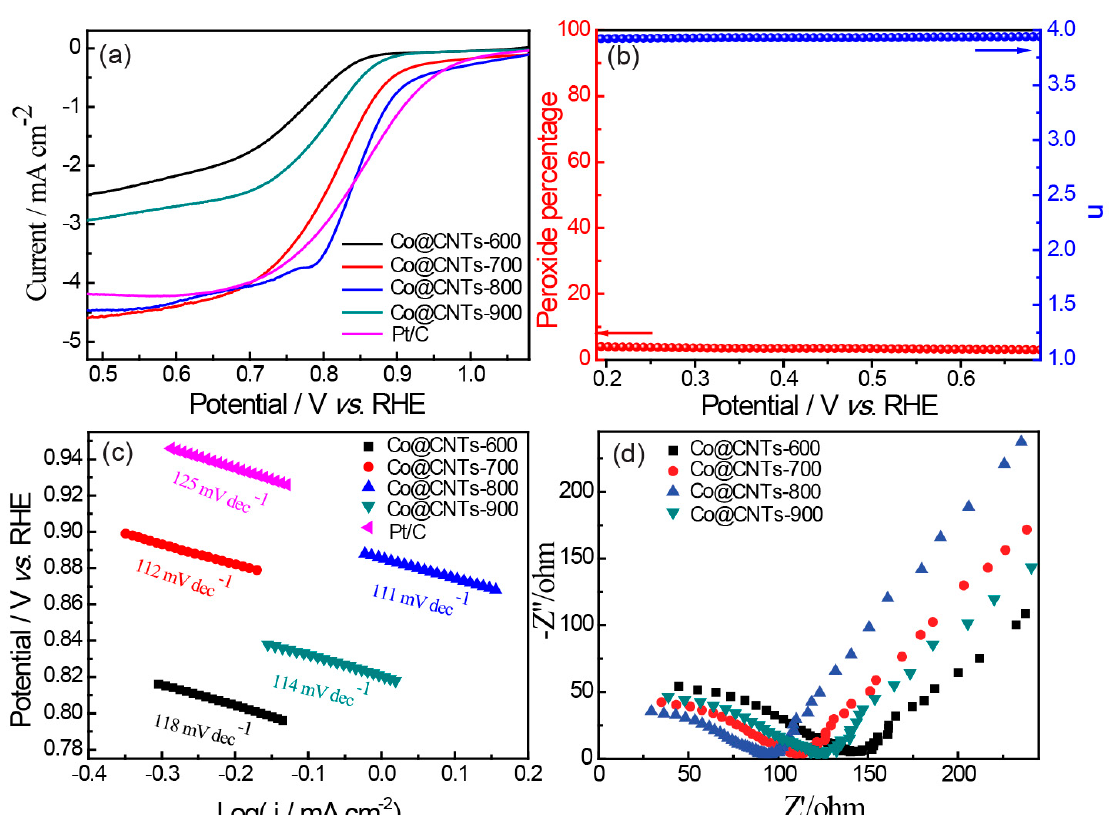
Figure 5. ( a ) LSV curve of Co@CNTs-T (T = 600, 700, 800 and 900, respectively) and a commercial Pt/C catalyst (1600 rpm); ( b ) Electron transfer number and peroxide percentage of Co@CNTs-800; ( c ) Tafel plots of Co@CNTs-T (T = 600, 700, 800, and 900, respectively) and a commercial Pt/C; ( d ) Nyquist plots of Co@CNTs-T (T = 600, 700, 800, and 900, respectively).